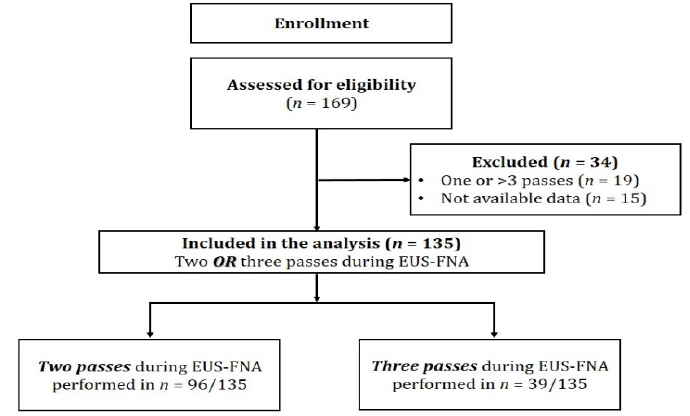
Figure 2. Study Figure 2. Study flowchart. Table 1. Patient` baseline clinical and procedural characteristics.